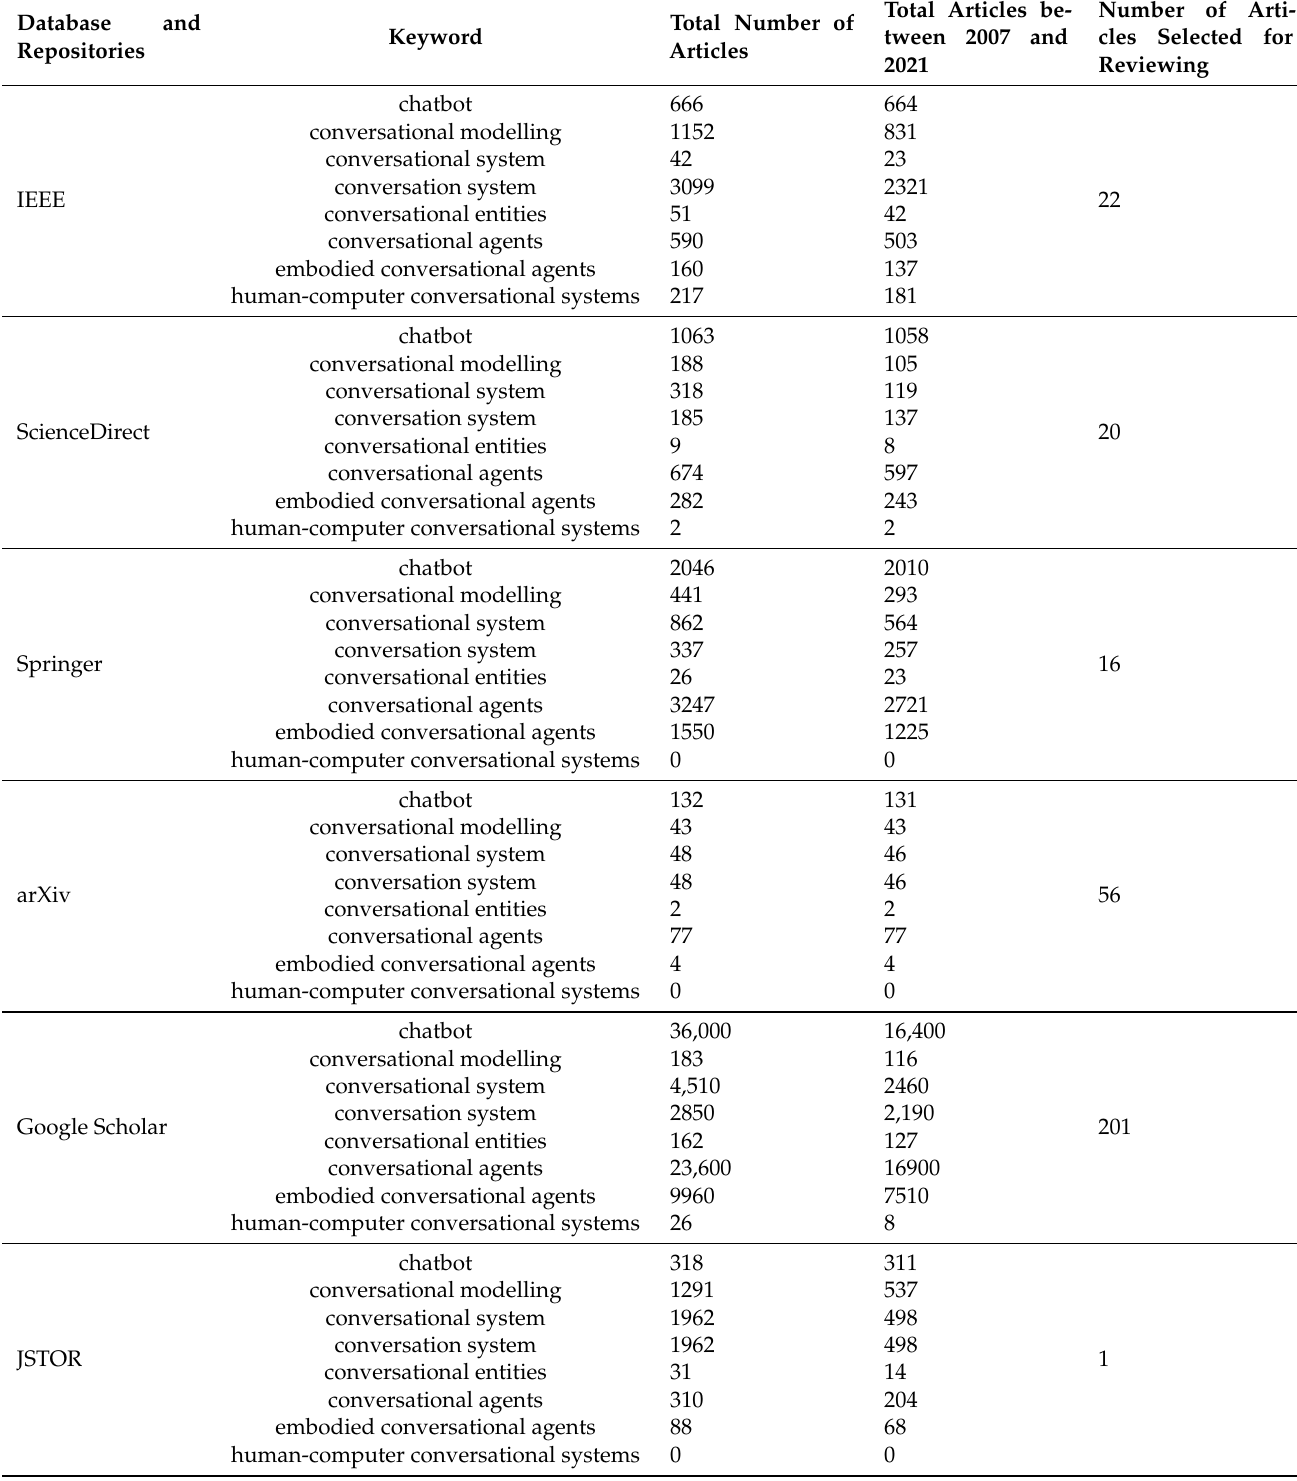
Table 1. Number of Article by search